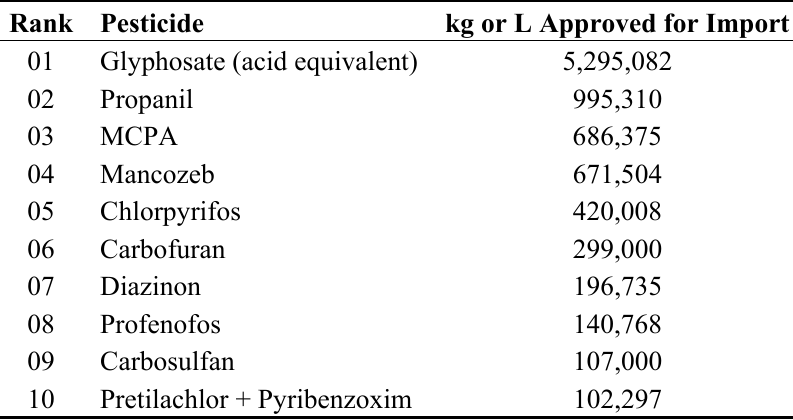
Table 1. Leading Pesticides imported to Sri Lanka in